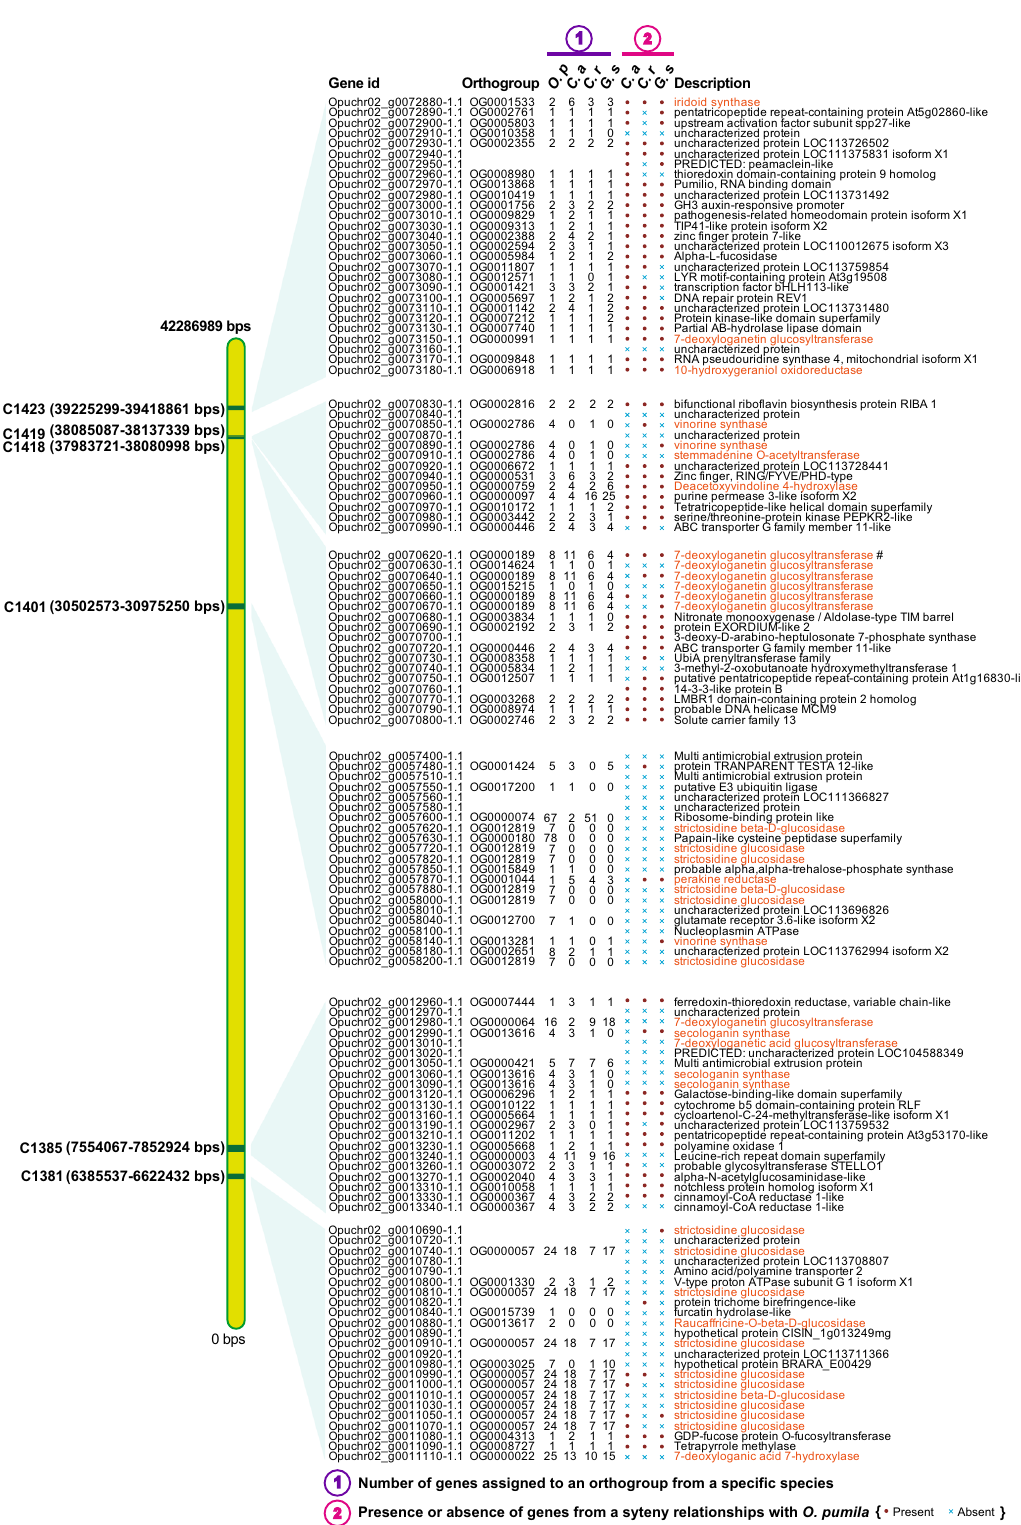
Fig. 7 Monoterpene indole alkaloid gene clusters identi fi ed in chromosome 2 in the Ophiorrhiza genome. In total, we identi fi ed 33 MIA gene clusters in Ophiorrhiza genome distributed across eight of its chromosomes (Supplementary Figs. 42 – 48). Conserved synteny at gene clusters across MIA-producing plants suggest role of secondary metabolite clusters toward evolution of specialized metabolites in plants. The position of the gene cluster is scaled based on chromosome size and its physical position on the chromosome. The gene description colored as orange represents genes with functions associated with MIAs biosynthesis. O.p Ophiorrhiza pumila , C.a Camptotheca acuminata , C.r Catharanthus roseus , G.s Gelsemium sempervirens